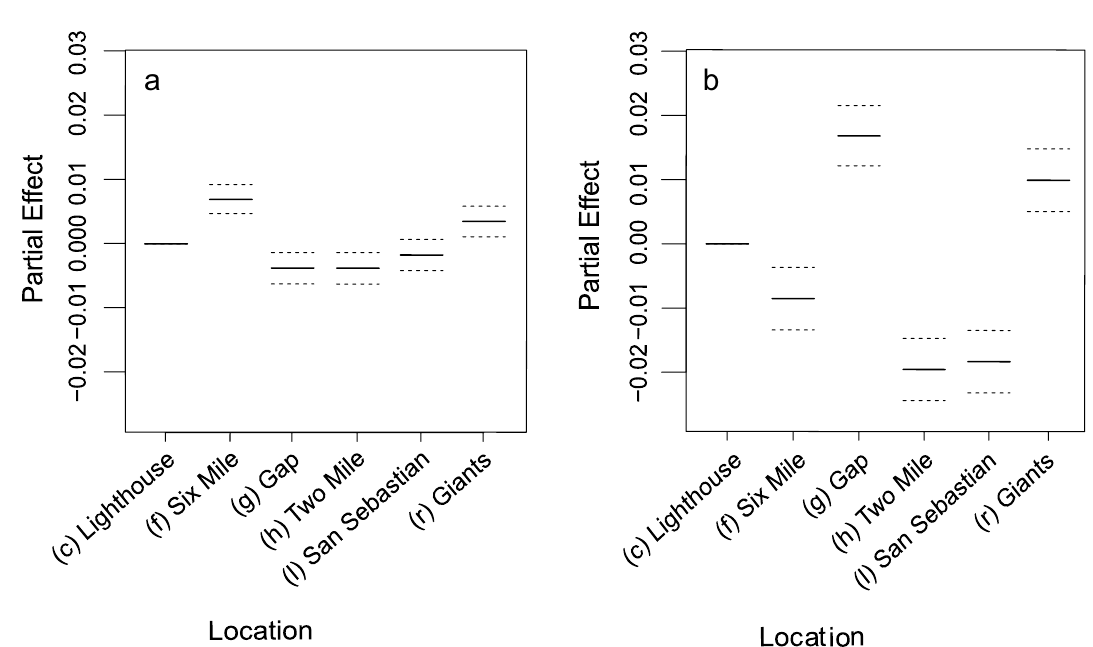
Figure 2. Partial effects of receiver location ( a , b ) on recorded detection events for Carcharhinus leucas ( a ; n = 12) and Carcharhinus limbatus ( b ; n = 6) sharks. Location labels (c, f, g, h, l, r) reference Table 2 and refer to the locations that acoustic receivers were deployed across the Inhambane province of southern Mozambique. Solid lines refer to the partial effect of each receiver location on the frequency of detection events and dotted lines represent the confidence